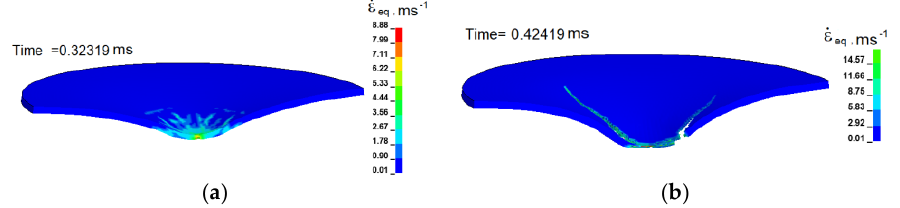
Figure 7. ( a ) Calculated distribution of effective strain rates in the cross section of punched Ti-5Al- 2.5Sn plate at the time of 0.32319 ms and ( b ) at the time of 0.42419 ms. The velocity of the punch is 15 m/s.